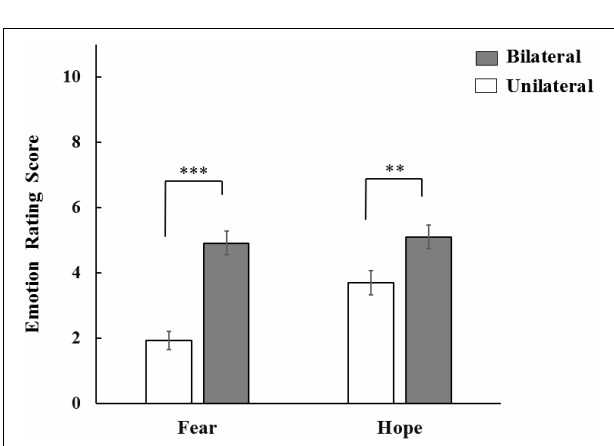
FIGURE 1 | The effect of bilateral/unilateral condition on preemptive behavior.